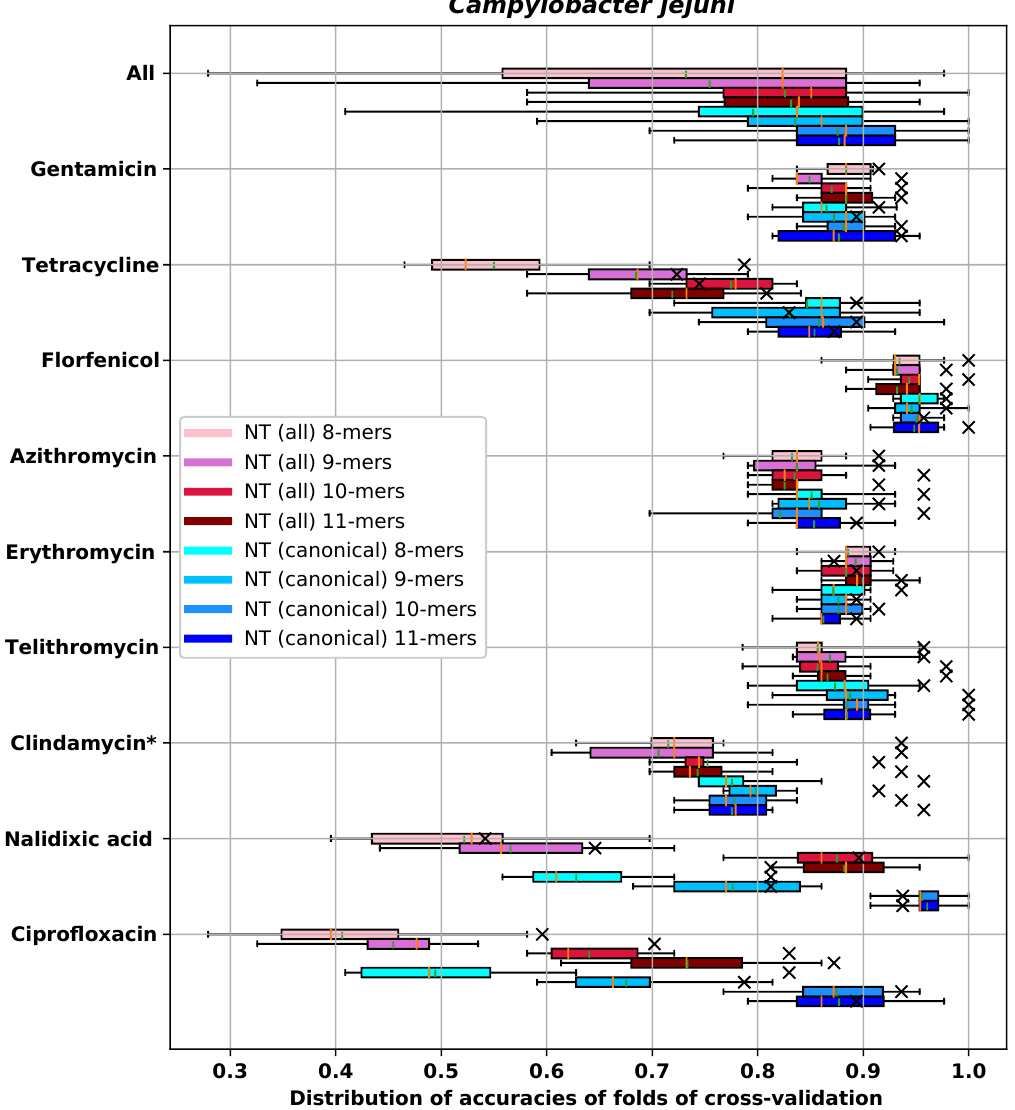
Figure A8. Distribution of accuracies in different nucleotide k -mers for C. jejuni . Plots are similar to Figure